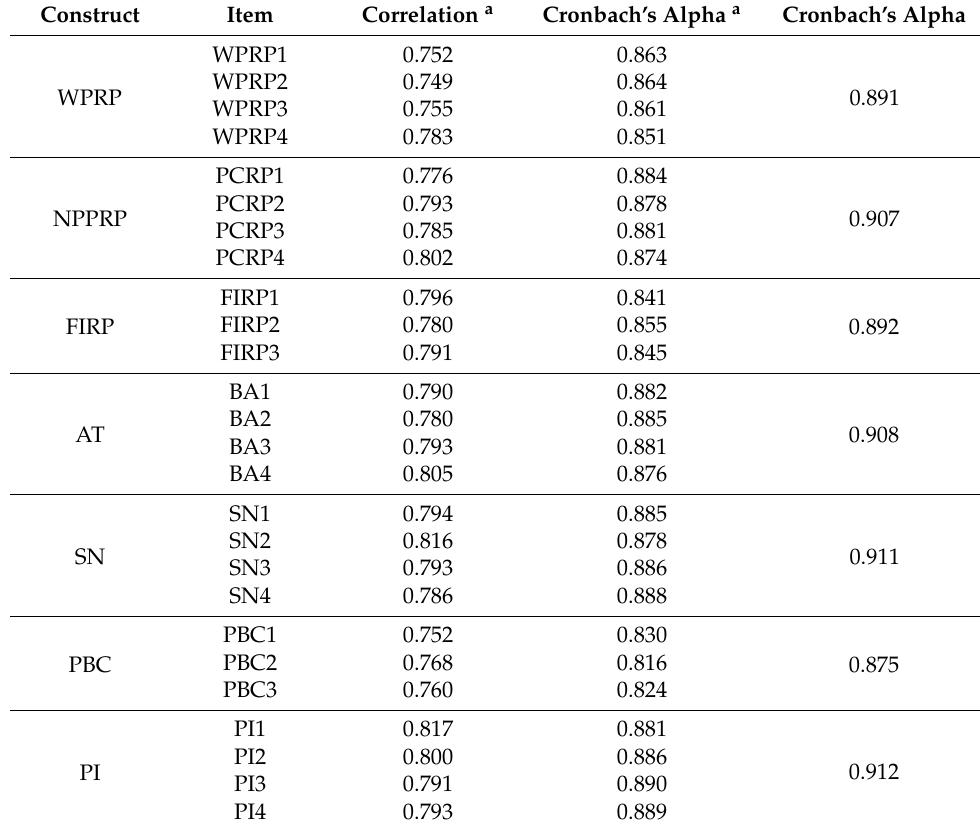
Table 2. Reliability